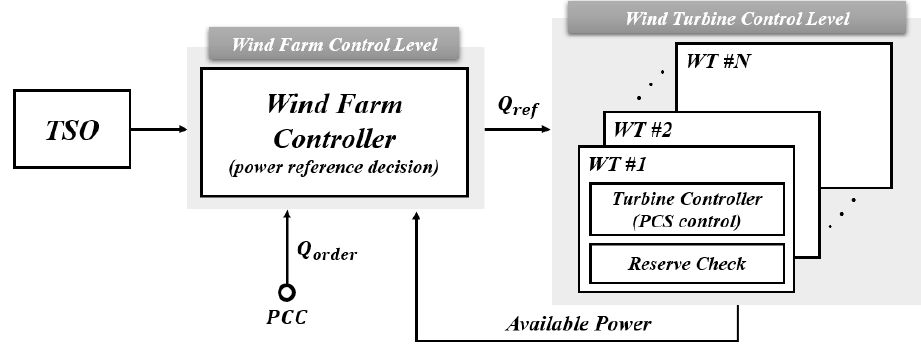
Figure 1. Centralized control structure for reactive power.